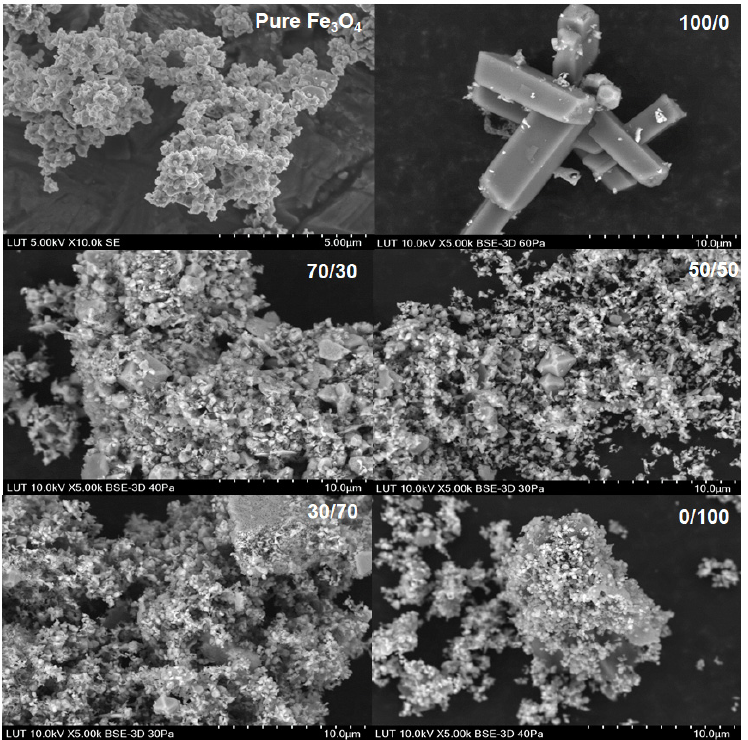
Figure 8. SEM images for the original Fe 3 O 4 powder dissolved in different acid systems (Ox/HNO 3 ).